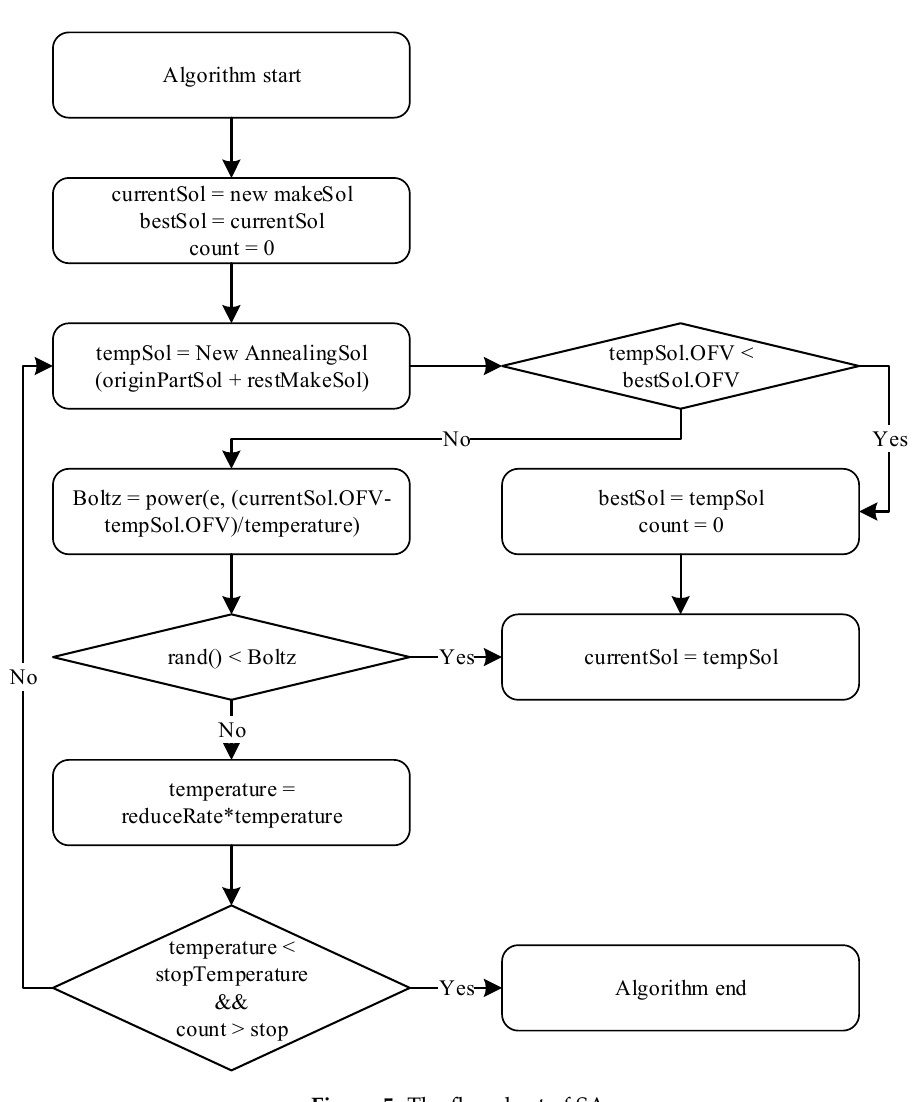
Figure 5. The flowchart of SA.